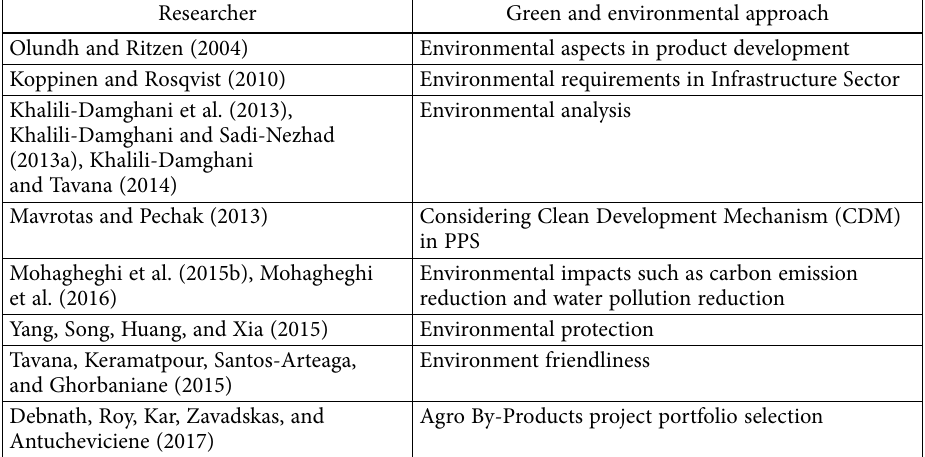
Table 5. Applying green and environmental criteria in PPS